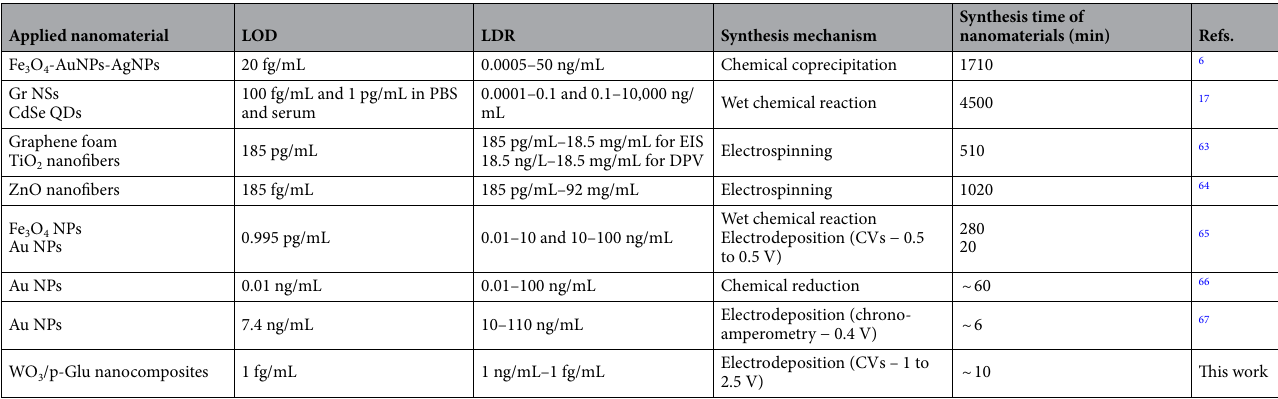
Table 1. Comparison of the proposed biosensor with the other previously reported platforms for HER-2 protein.